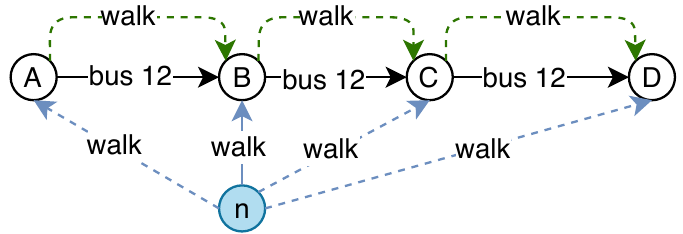
Figure 2. Example of pruning footpath arcs.